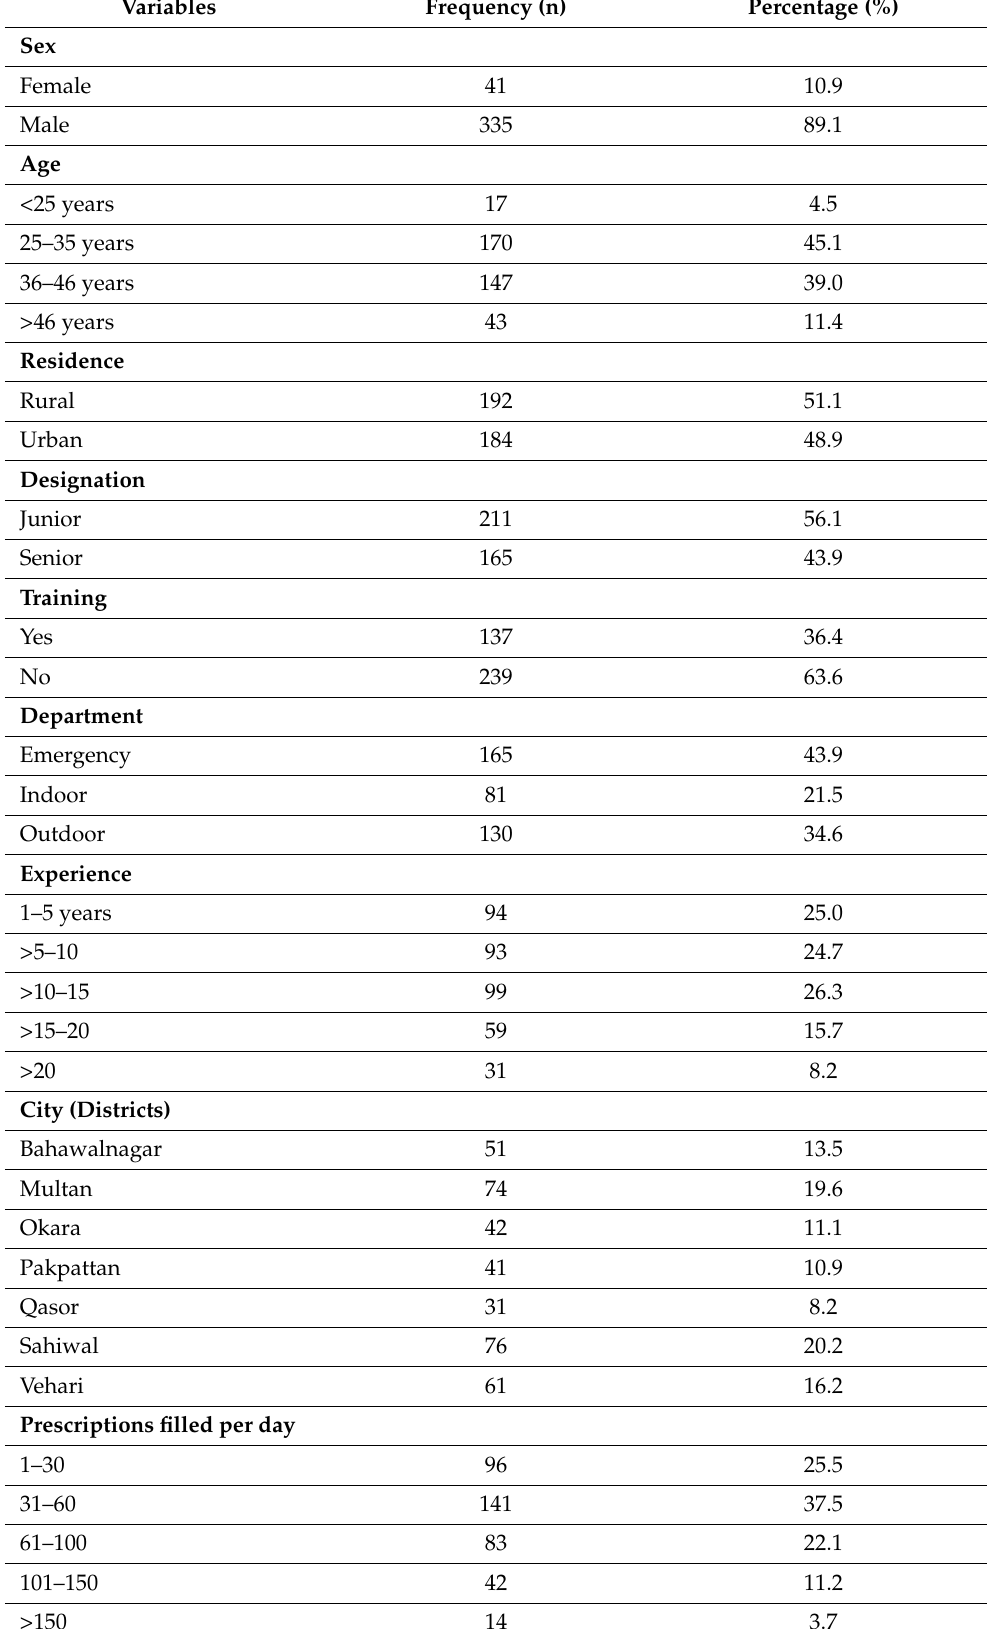
Table 1. Demographic characteristics of the pharmacy technicians (n =